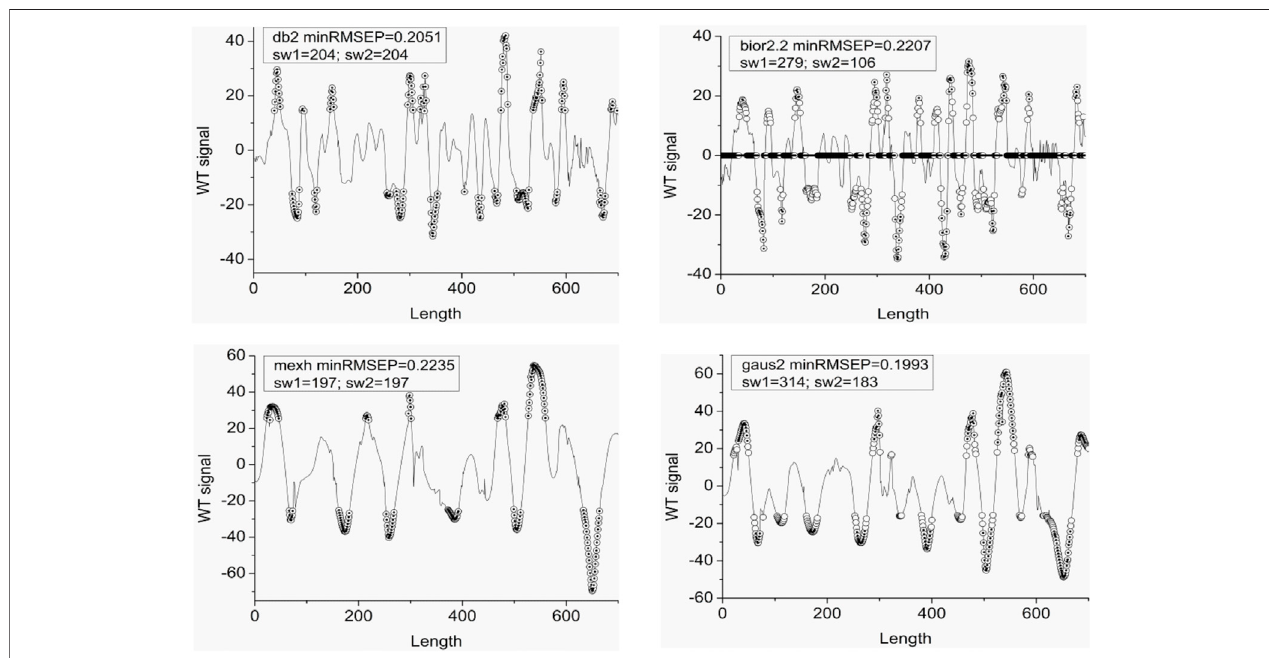
FIGURE 7 | Some select valuable signal points by UVE after WT. minRmsep is the minimum RMSEP value after 100 times UVE. sw is the selected spectrum point number.